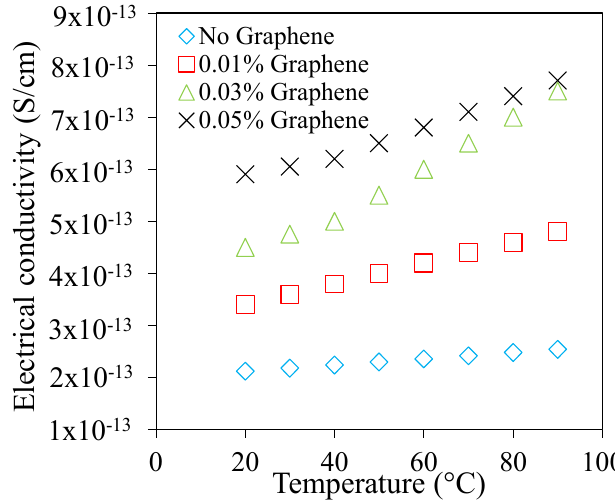
Figure 7. Variation of electrical conductivity of graphene–transformer oil nanofluid with temperature.